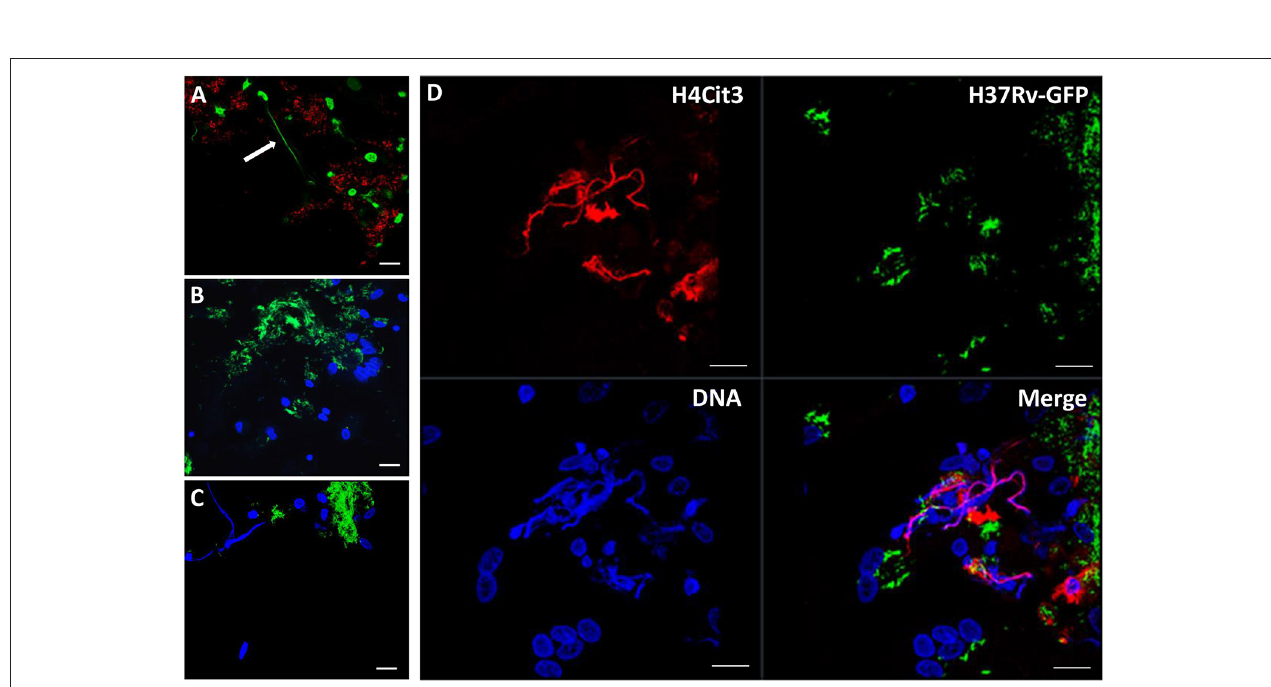
FIGURE 4 | METS are composed of DNA. Macrophages were infected with the cording, (A) Cherry-expressing H37Rv or (B–D) GFP-expressing H37Rv and fixed after 24 h. DNA was stained with (A) picogreen or with (B–D) DAPI. (B) No METs were observed in cells treated with DNase I before fixation. (D) Immunofluorescence staining of citrullinated histone 4 (red) and co-staining with DAPI (blue) suggests that the DNA in METs is of nuclear origin. Scale bar: 20 µ m.